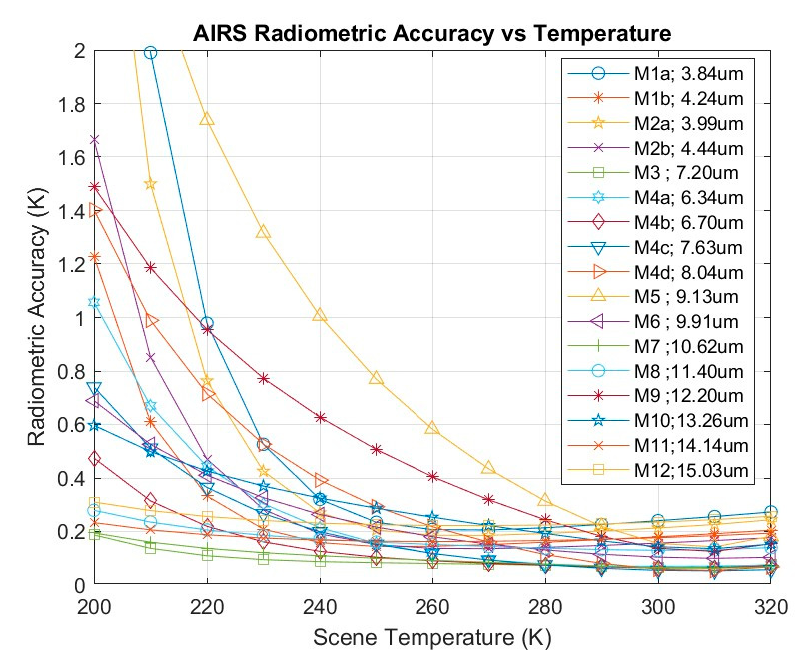
Figure 8. Radiometric uncertainty vs. temperature for V5.